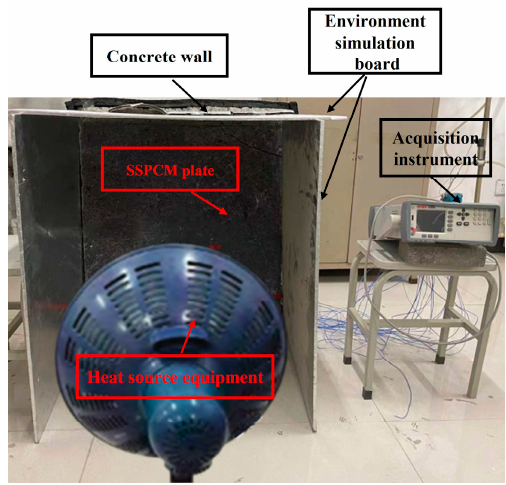
Figure 5. The experimental platform of the SSPCM granary wall.